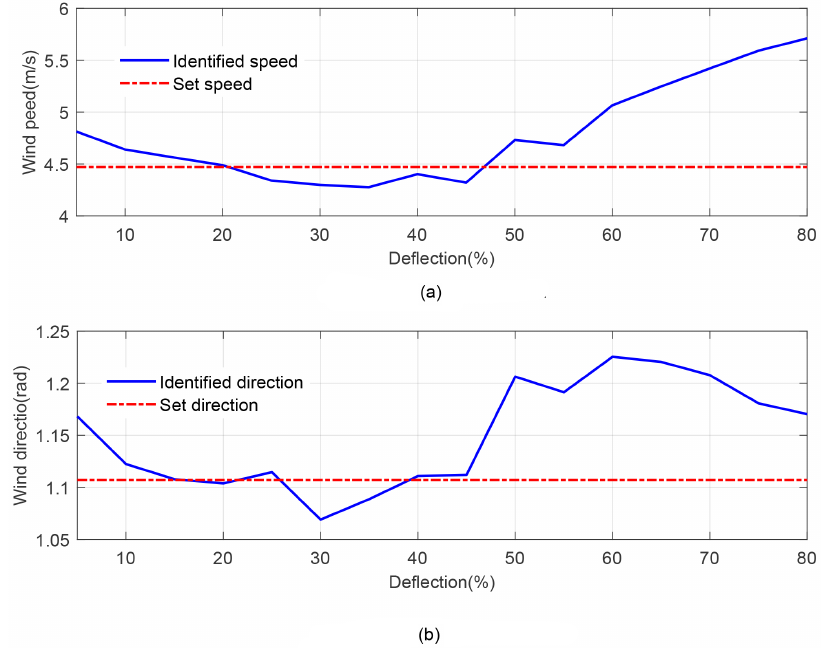
Figure 7. Error distribution under unilateral deflection. ( a ) Speed error distribution. ( b ) Direction error